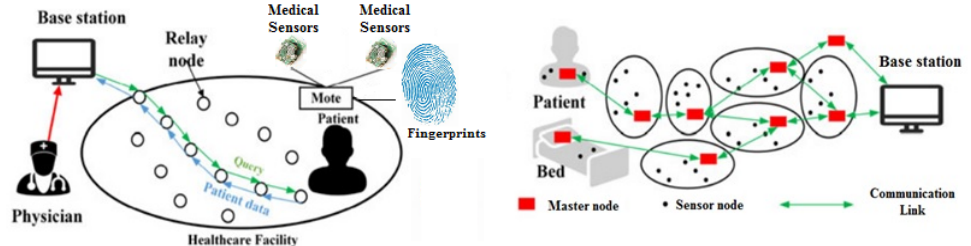
Figure 2. The framework for the medical SNAP model, modified based on [14,20].